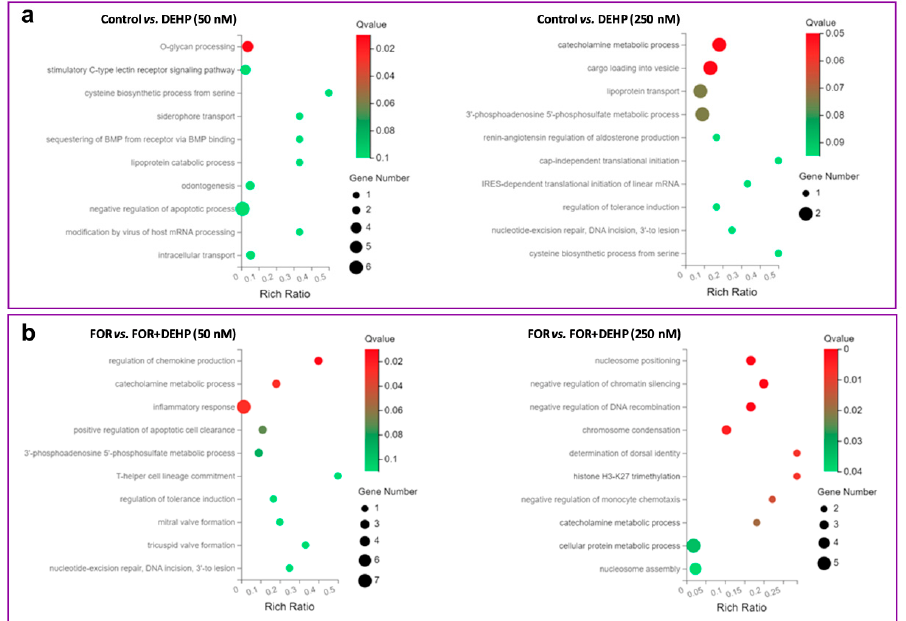
Figure 6. Ten top-ranked biological processes deregulated in DEHP-exposed HGrC1 cells. Summary of deregulated biological processes during four weeks of the repeated exposure to DEHP50 and DEHP250 under the ( a ) basal and ( b ) FOR-stimulated conditions. A greater rich factor represents a greater degree of enrichment. A Q value represents a corrected p value. A Q value ≤ 0.05 is regarded as a significant enrichment.